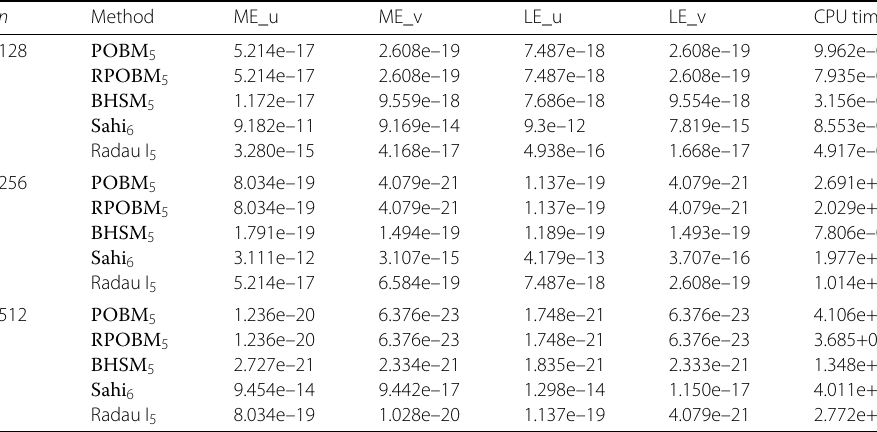
Table 4 Comparison of the methods under consideration on the basis of absolute errors and